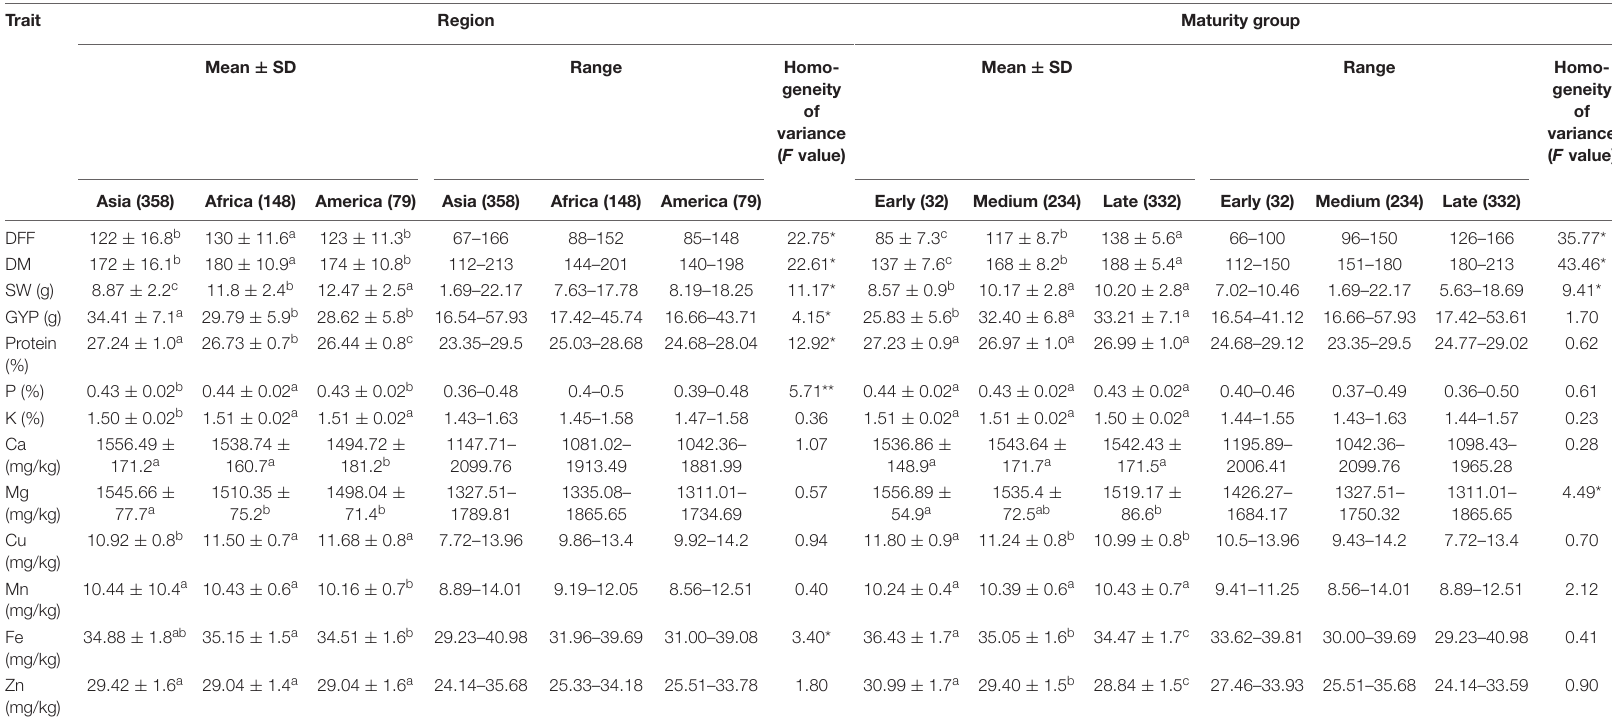
The value inside the parenthesis represents the number of accessions in each category. SD, standard deviation; DFF, days to 50% flowering; DM, days to maturity; SW, 100-seed weight; GYP, grain yield per plant; P, phosphorus; K, potassium; Ca, calcium; Cu, copper; Mg, magnesium; Mn, manganese; Fe, iron; Zn, zinc. The mean followed by the same letters is not significant at p ≤ 0.05, and the mean followed by different